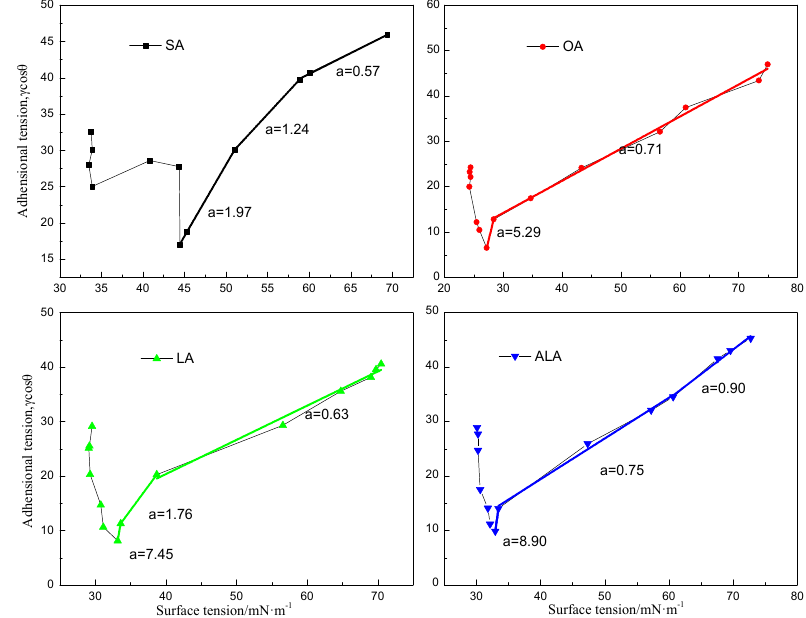
· cos θ as a function of γ Figure 7. γ LG ·cos θ as a function of γ LG of fatty acid solutions. Figure 7. γ LG